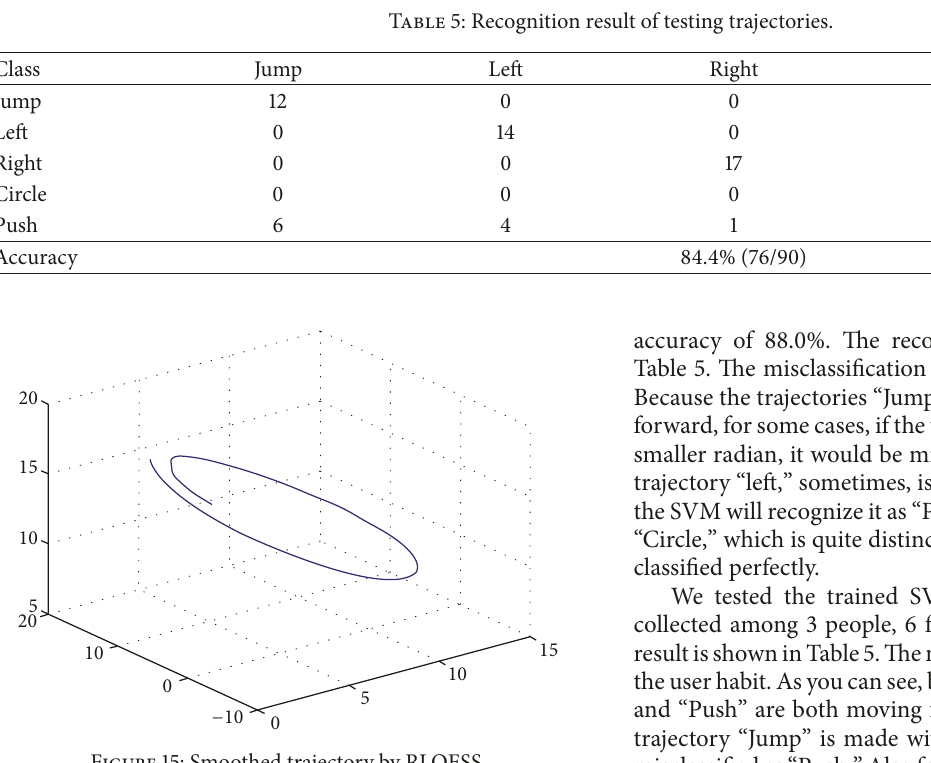
Figure 15: Smoothed trajectory by